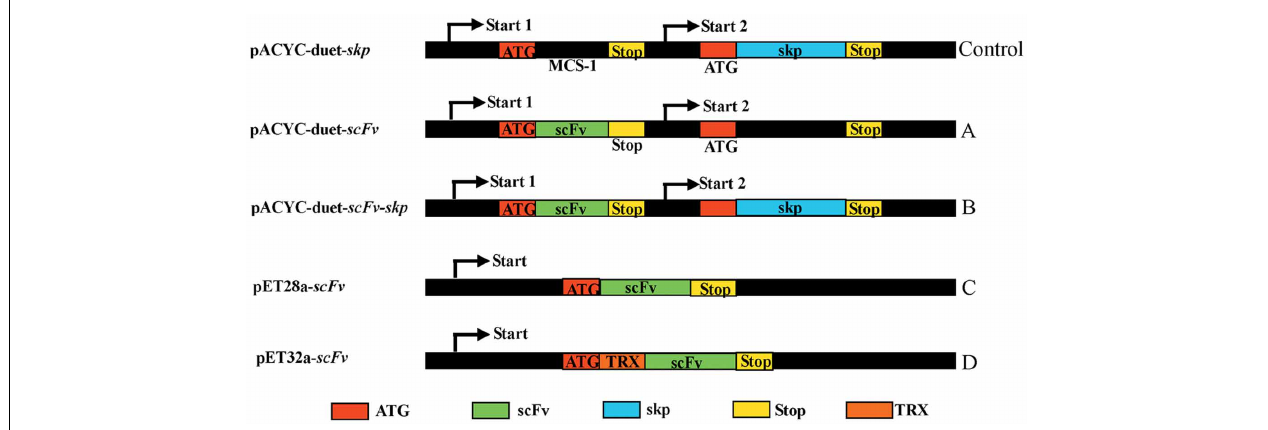
each at the N- and C-terminal, respectively, while the expres- sion vector pET32a- scFv encodes a TRX-scFv fusion protein with two 6 × His tags, one each at the N-terminal and C-terminal, respectively.